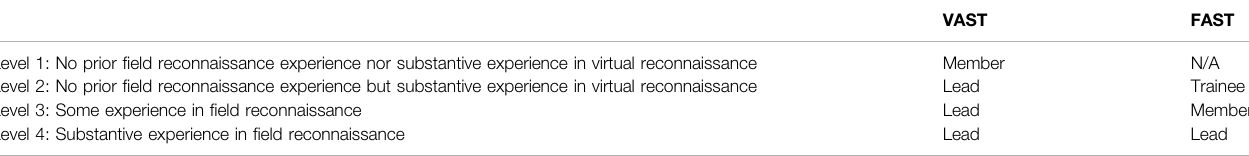
TABLE 1 | Membership levels and corresponding participation